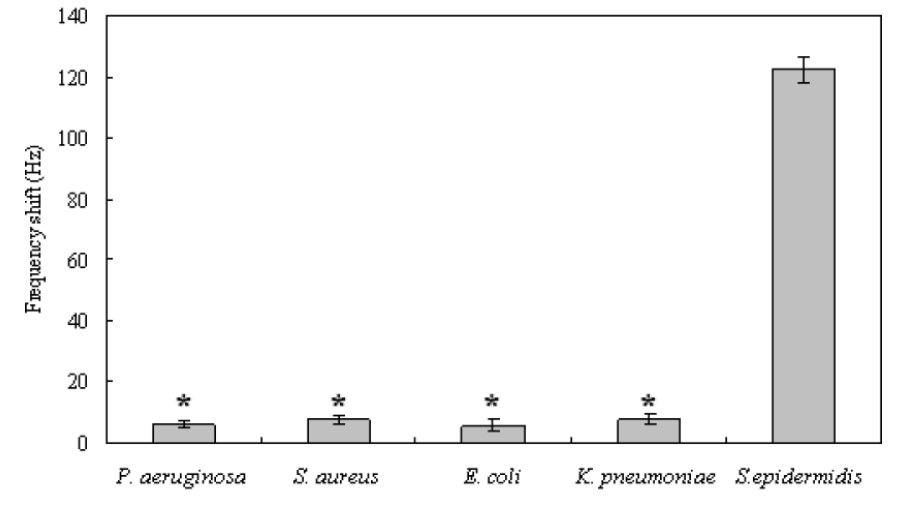
Figure 9. Frequency shifts of the QCM biosensor for PCR-amplified DNAs of 5 bacteria. PCR products of S. epidermidis (ATCC 12228), P. aeruginosa (ATCC 27853), S. aureus (ATCC 25923), E. coli (ATCC 25922), and K. pneumoniae (ATCC 700603) with the concentration of 1.3×10 7 CFU/mL were detected by the Au nanoparticle signal amplification based QCM biosensors. Error bars indicate the standard deviation (n=5). * indicates P ﹤ 0.05 vs. PCR products of 1.3×10 7 CFU/mL S. epidermidis ATCC